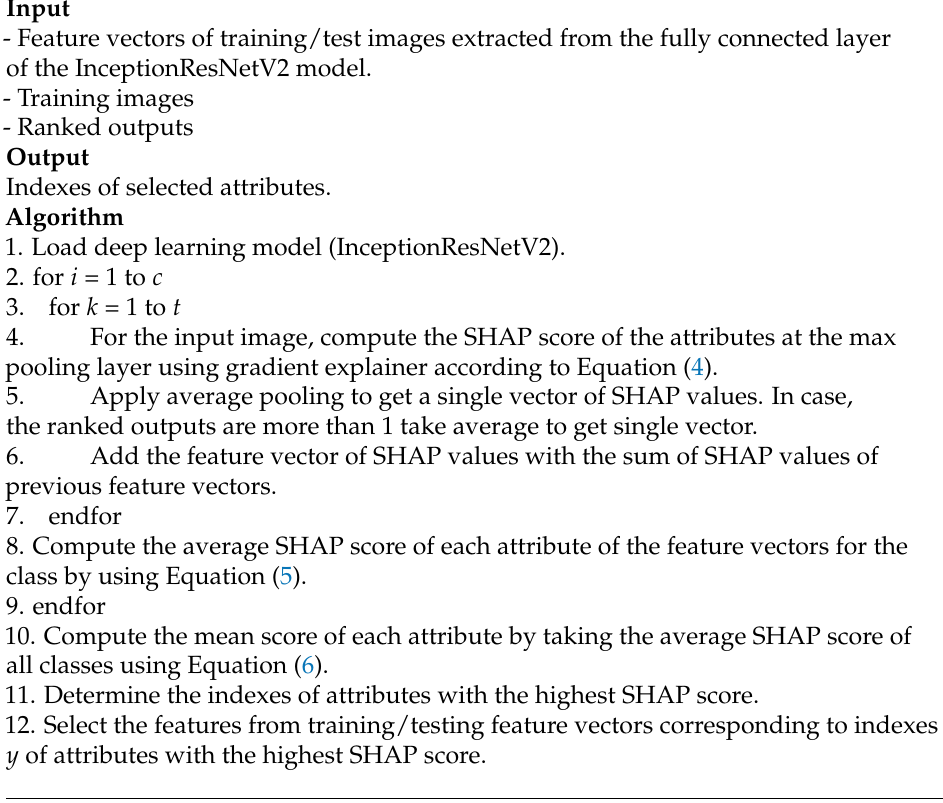
Algorithm 1 Feature selection steps based on Gradient/Deep